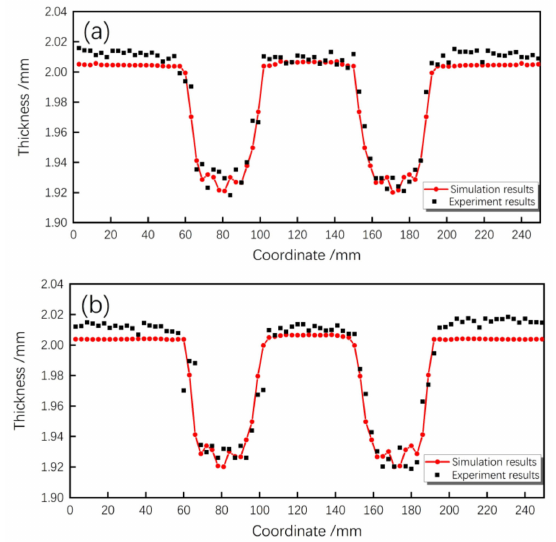
Figure 26. Comparison of the thickness between numerical simulation of the U-shaped part and the blank used in the experiment. ( a ) TPP-S; ( b )